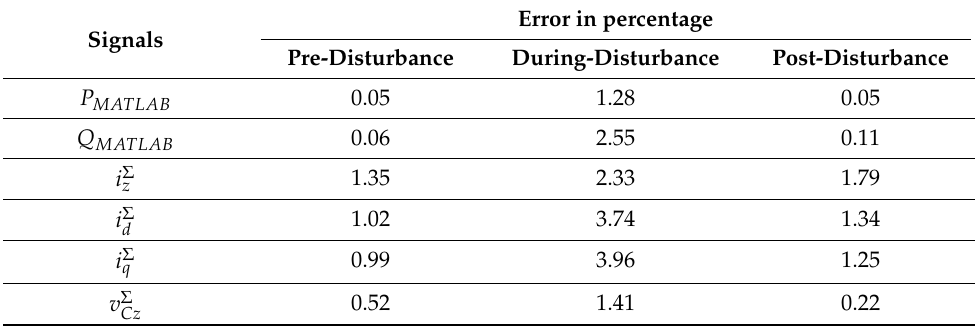
Table 5. MAE in the mathematical model during active power reversal at t = 0.6